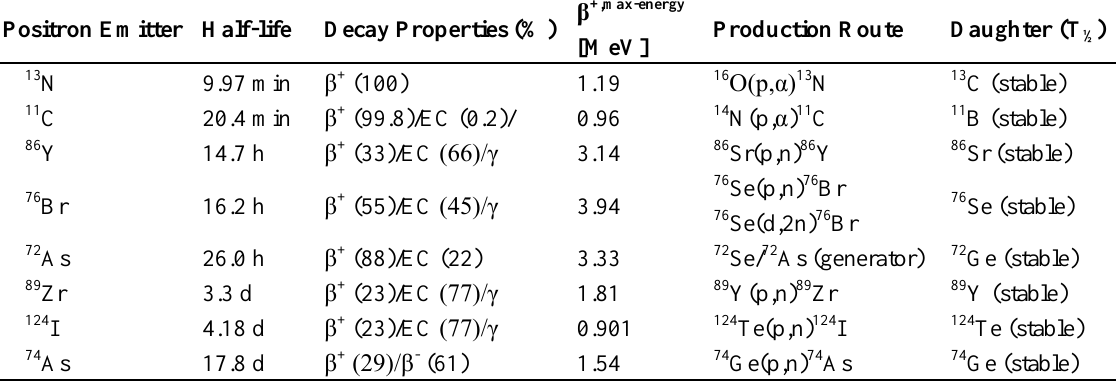
Table 4. Further positron emitters used for radiolabeling of polymers and nanoparticles and their decay properties [13,60–62].